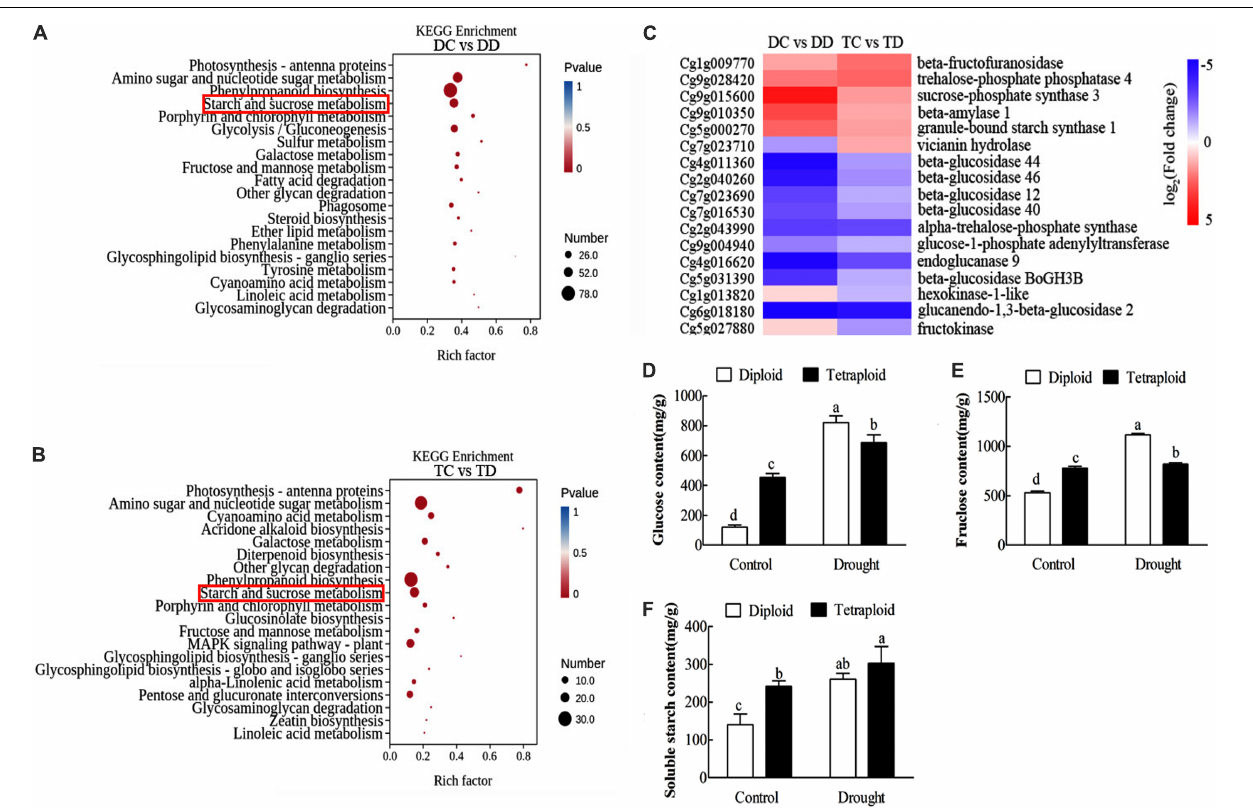
FIGURE 7 | Kyoto Encyclopedia of Genes and Genomes enrichment and hierarchical clustering analysis of the DEGs as well as the physiological analysis between tetraploids and diploids Citrus wilsonii in response to drought stress. The top 20 pathways with the highest enrichment level were exhibited according to the amount and enrichment level of DEGs annotated in DC vs DD (A) and TC vs TD (B) , respectively; hierarchical clustering analysis of the DEGs in starch and sucrose metabolism (C) ; the contents of glucose (D) , fructose (E) and soluble starch (F) analysis between tetraploids and diploids Citrus wilsonii in response to drought stress. Each value is the mean of three biological replicates, and the vertical bars represent the standard errors. Values sharing the same lower case letters are insignificant as ANOVA at P <